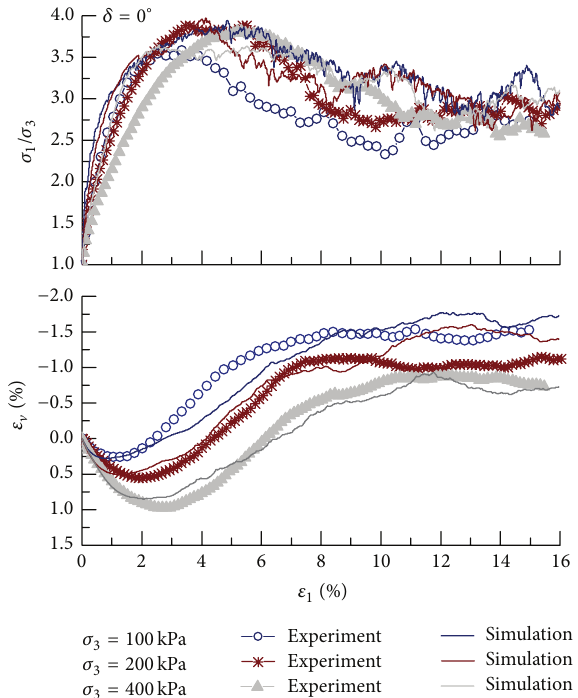
Figure 6: Stress-strain relationship comparison between experi- ments and simulations under different confining